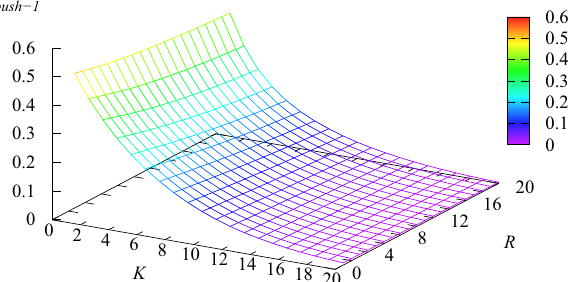
Figure 20. Dependence of the probability P push − 1 that an arbitrary Type-1 request upon arrival will push the first request from the intermediate buffer to the main buffer on K and R .